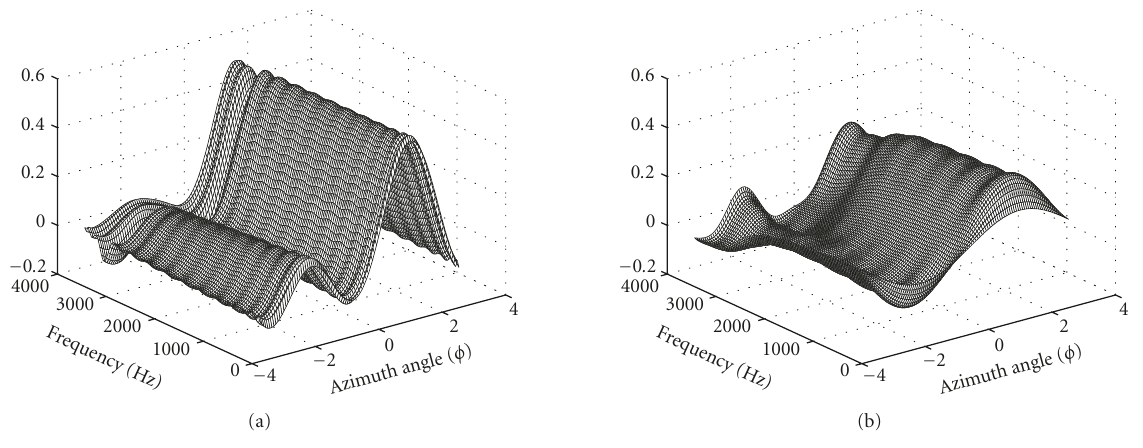
Figure 3: Frequency-invariant beamforming. (a) optimal beampattern for 5-element UCA with half-wavelength spacing and Nyquist sam- pling at the highest design frequency (5 elements, 32 time samples); (b) optimal beam pattern for UCA with the same radius as above, but only with 3 sensor elements and a halved sampling rate (16 samples).